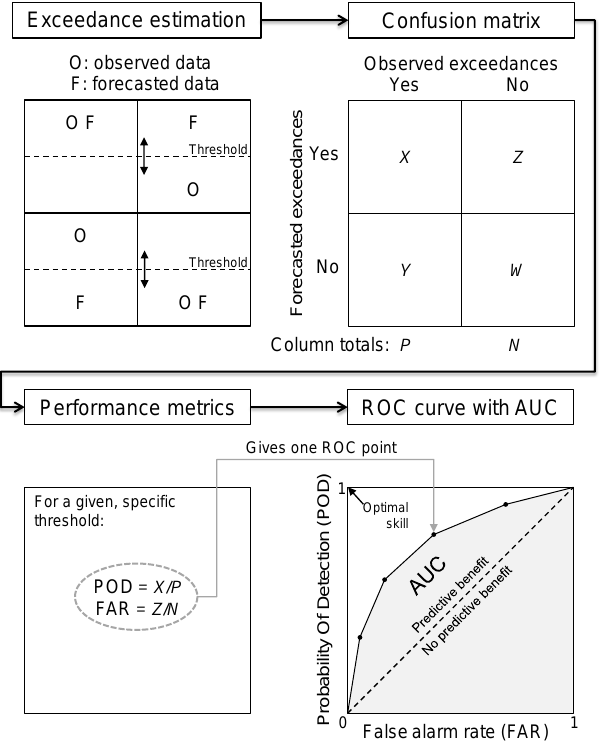
Figure 2. Typical work flow for deriving threshold-exceedance based skill scores, e.g., False Alarm Rate, Probability Of Detec- tion (FAR, POD) or combined products, e.g., Receiver Operating Characteristic (ROC) curves and Area Under Curve (AUC)